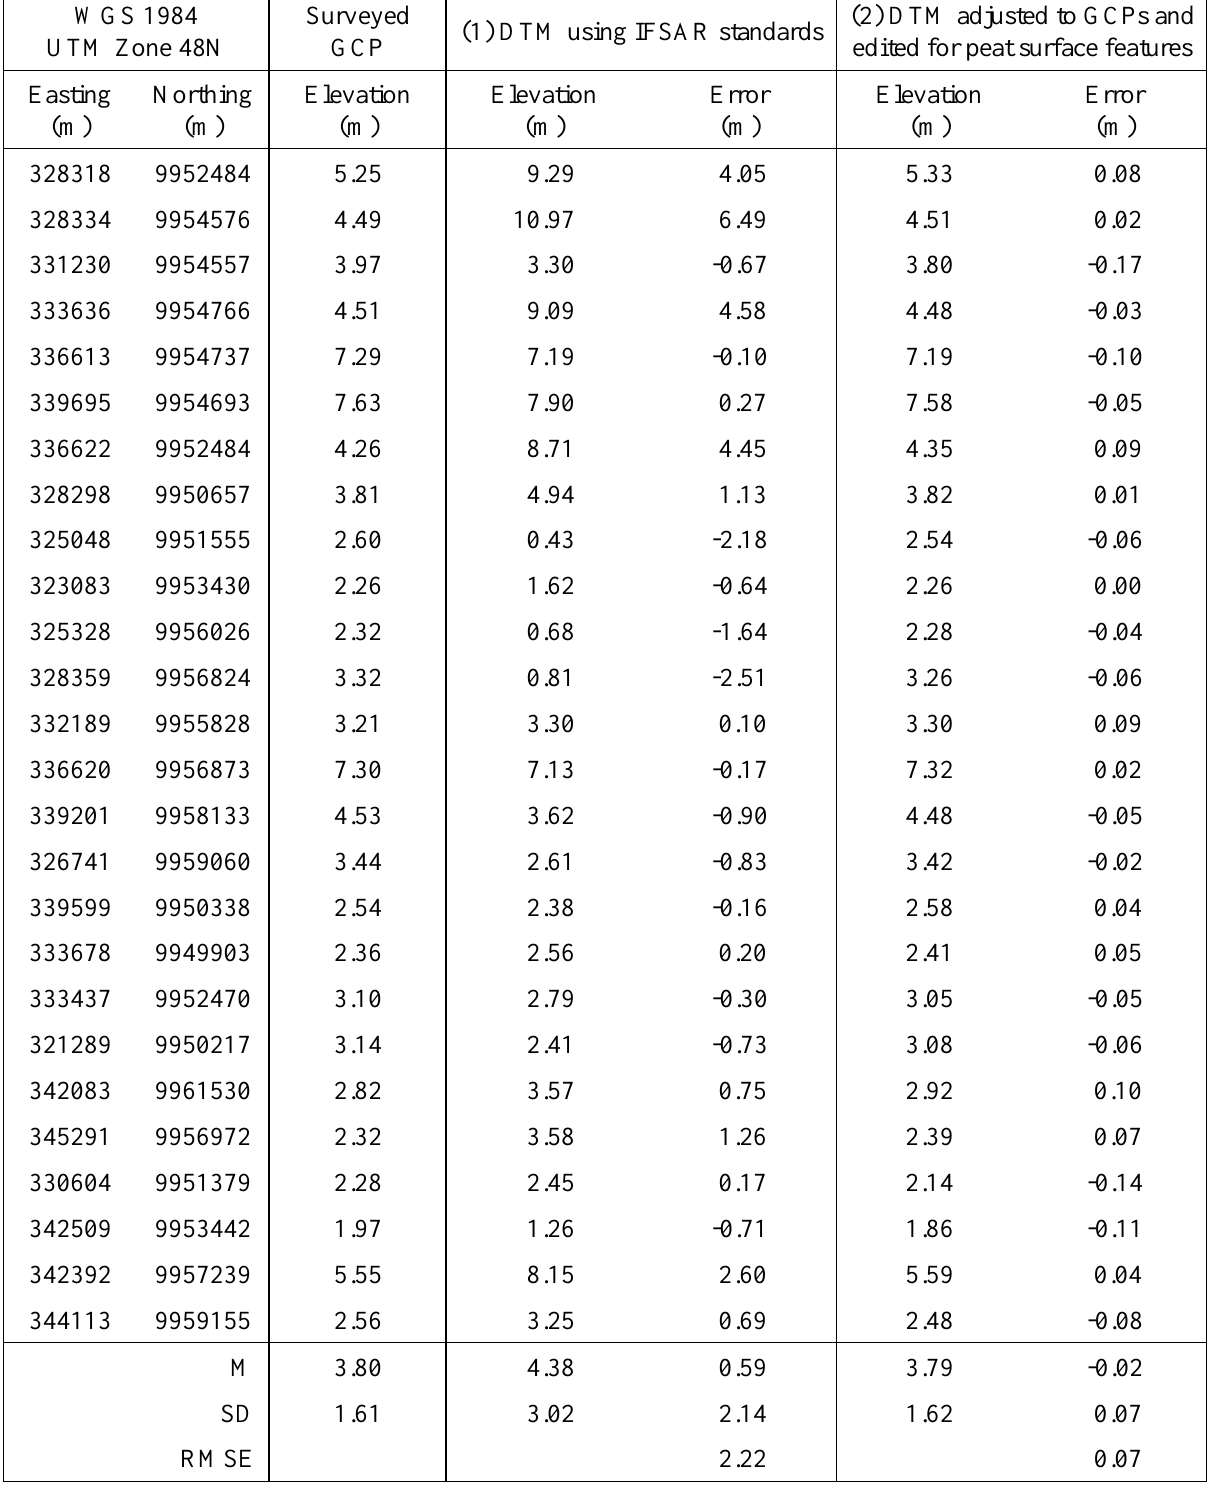
Table A1. Accuracy of the DTM at Bengkalis by comparison with surveyed Ground Control Points (GCPs); (1) after standard processing from an IFSAR DSM and (2) after further processing to include ongoing peat surface dynamics and exclude man-made